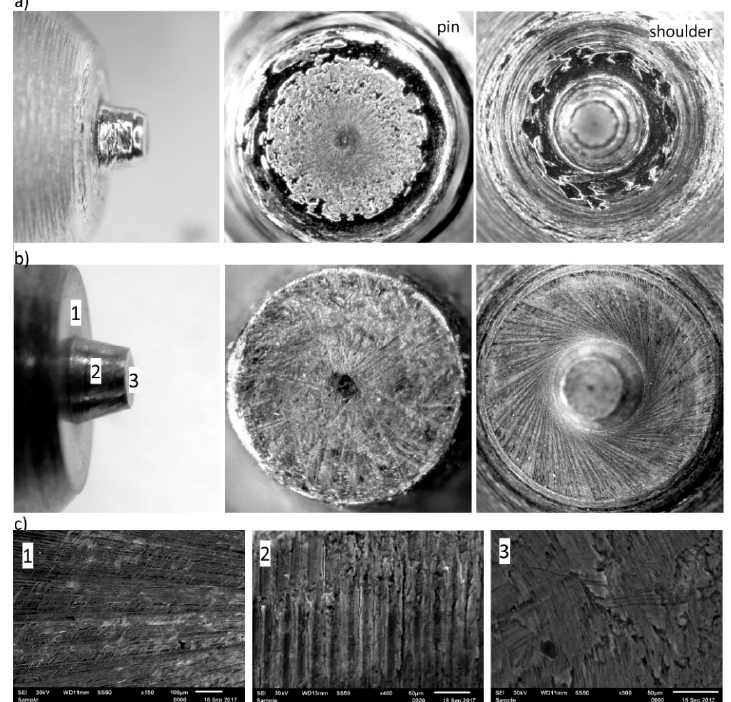
Figure 8. Tool working surfaces (pin and shoulder) after the second stage of testing (joint length of approximately 200 m): ( a ) tool made of 1.2344 steel, ( b ) tool made of AlCrN-coated 1.2344 steel, ( c ) microscopic images (SEM) of the tool surface after machining. ( 1 ) shoulder surface, ( 2 ) side surface of a pin, ( 3 ) frontal surface of a